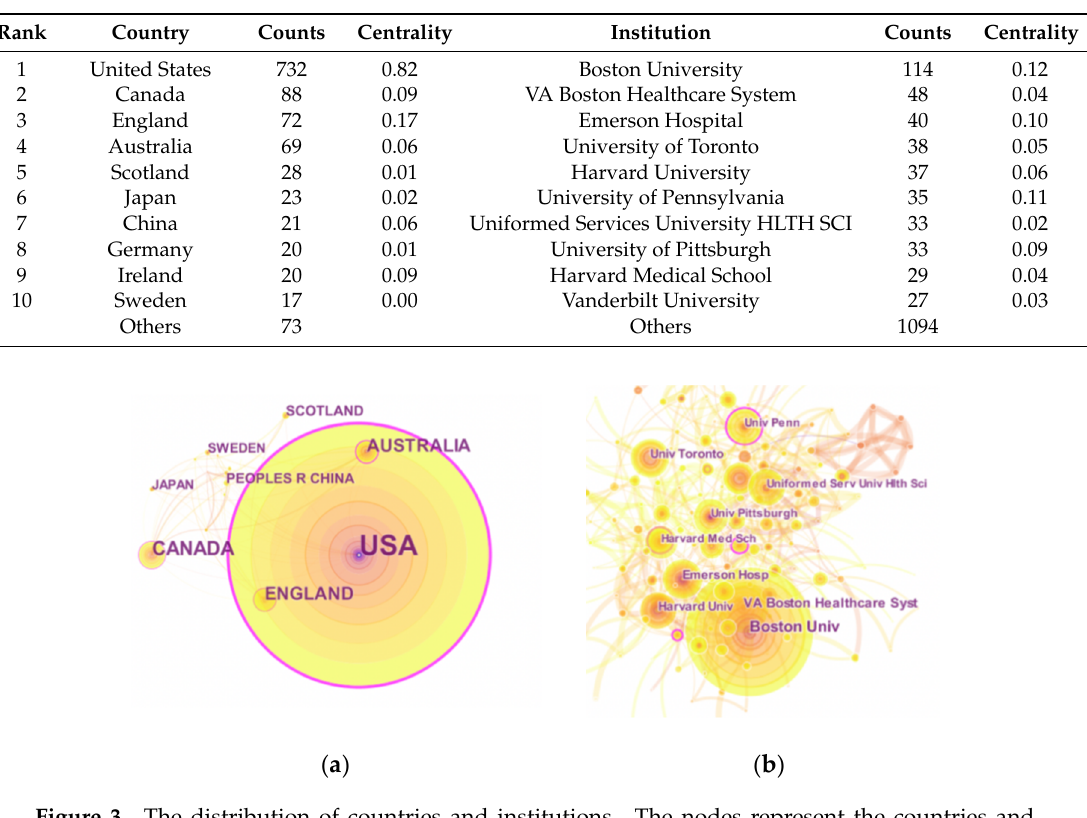
Figure 3. The distribution of countries and institutions. The nodes represent the countries and institutions; the color depth and size of the circle are positively correlated to the number of posts. The thickness of the curved connecting lines represents the strength of collaboration in the countries and institutions. ( a ) Map of countries with publications on CTE. ( b ) Map of institutions with publications on CTE.